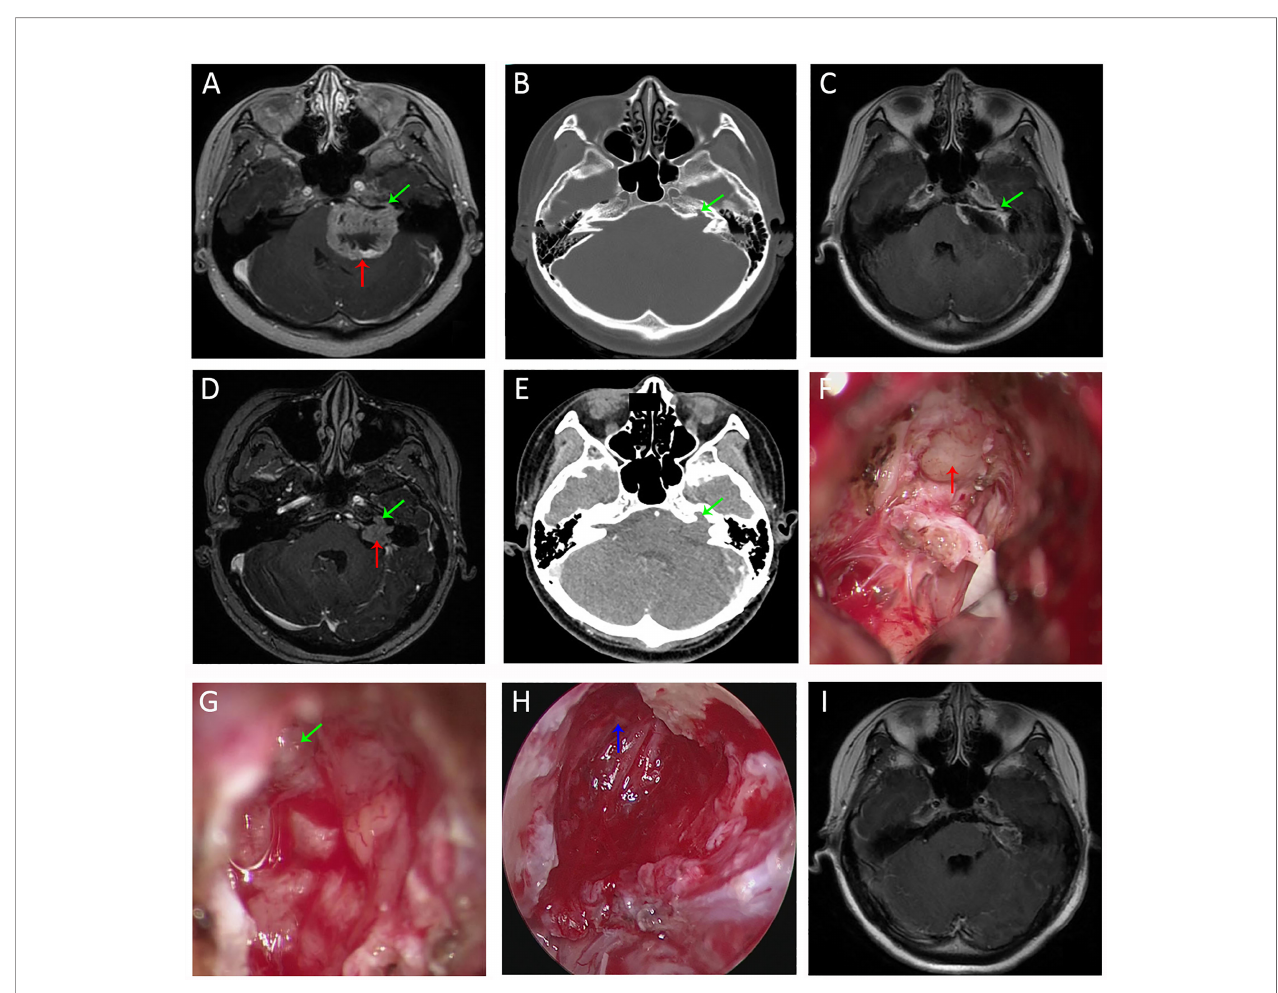
FIGURE 5 | Imaging studies and intra-operative snapshots of a case of vestibular schwannoma with irregularly shaped tumor extending into the IAC. (A) The initial pre-operative T1WI with contrast revealed a giant vestibular schwannoma abutting the brainstem (red arrow). The intracanalicular portion of the tumor was irregularly shaped as indicated by the green arrow. (B) The bone proper of the fundus of IAC was eroded (green arrow). (C) TIWI with contrast after microscopic resection revealed tumor remnants (green arrow) within the bony corridors of the eroded IAC fundus. (D) Pre-operative T1WI of the second operation (3 years after the initial surgery) revealed recurrent tumors within IAC. The intracanalicular portion was irregularly shaped, and the extracanalicular portion had extension into CPA. (E) Pre- operative CT of the second operation revealed further destructions of the IAC fundus compared with the fi rst operation (B) . (F) Intra-operative microscopic view of the second operation showed tumor extension to CPA. (G) There were still tumor remnants (the irregularly shaped intracanalicular portion, as annotated by green arrow) despite maximal resection under microscopic view. (H) Full removal of the tumor remnants (blue arrow) within the bony corridors of IAC. (I) Post-operative T1WI of the second operation indicated total removal of the intracanalicular portion of the tumor. Strict adhesions anterior to the brainstem prevented us from further resection. T1WI, T1 weighted image. CPA, cerebellopontine angle; IAC, internal acoustic canal; T1WI, T1 weighted